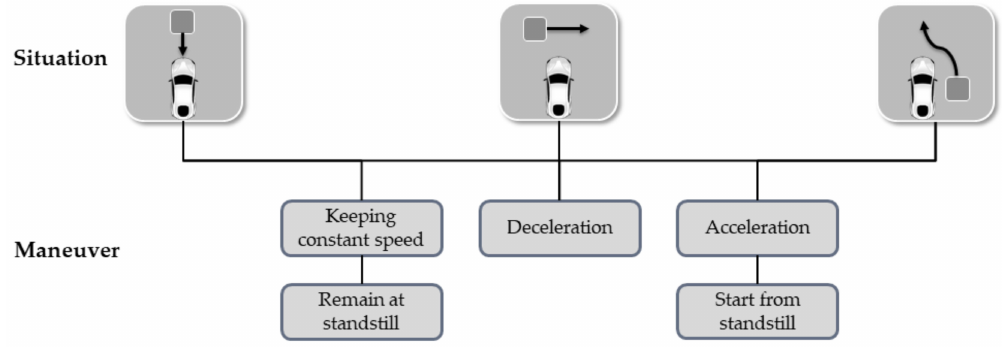
Figure 4. Combination of situations and maneuvers of the automated vehicle, resulting in context-independent use cases. Grey squares represent an arbitrary interaction partner, and the white vehicles represent automated